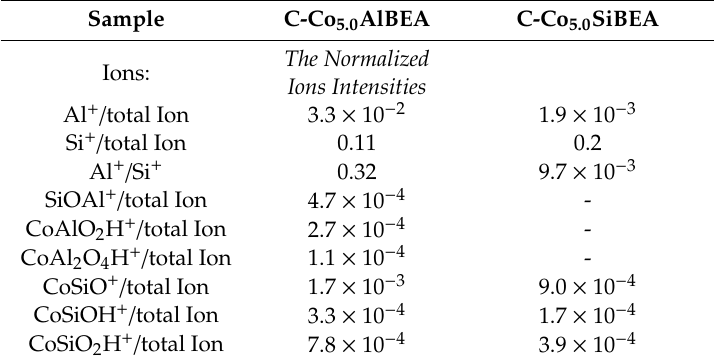
Table 2. The normalized intensities of secondary ions calculated using ToF–SIMS data obtained for C-Co 5.0 AlBEA and C-Co 5.0